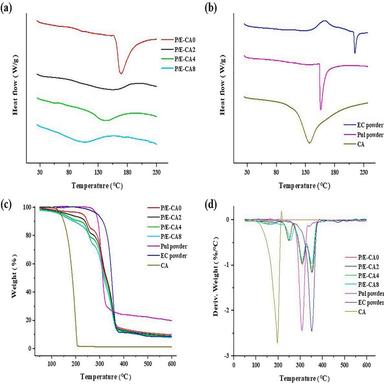
The DSC thermograms of (a) P/E-CA nanofiber films (b) Pul powder, EC powder, and CA. The TGA curves (c) and DTG curves (d) of nanofiber films, Pul powder, EC powder, and CA.